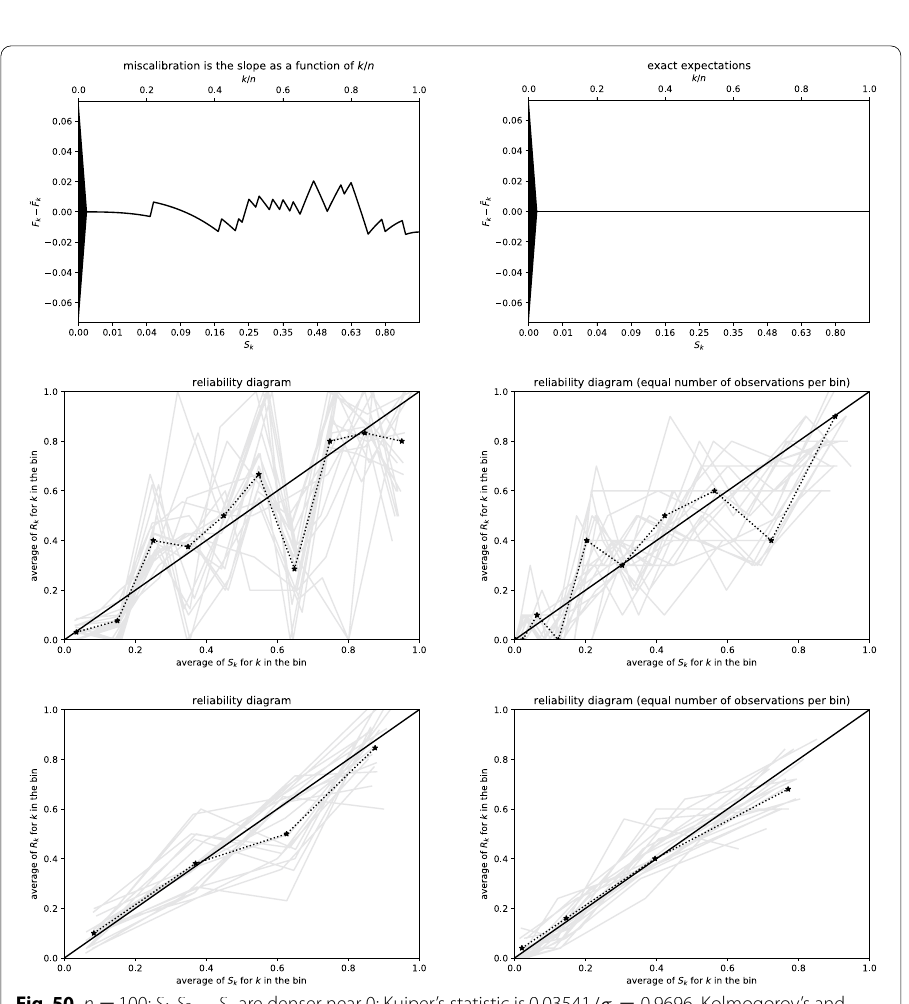
Fig. 50 n = 100; S 1 , S 2 , ..., S n are denser near 0; Kuiper’s statistic is 0.03541 /σ = 0.9696 , Kolmogorov’s and Smirnov’s is 0.02050 /σ = 0.5615 . Figure 51 displays the ground-truth reliability